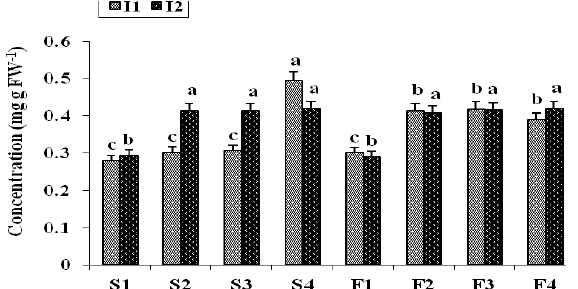
Fig. 5. Changes in superoxide dismutase activity due to water deficit stress and application of Fe;. I1- normal irrigation or irrigation to reach 50% soil moisture depletion of field capacity, I2 beginning of flowering to the end of pollination stage reaching 75% of soil moisture depletion of field capacity; S- soil application of Fe, S1 without soil application of Fe; S2- 50 Fe Kg ha -1 , S3 150 Fe Kg ha -1 ; F- foliar application of Fe, F1- foliar application of water, F2- 1,000 Fe mg l -1 , F3- 2,000 Fe mg l -1 , F4- 3,000 Fe mg l within each column of each section followed by the same letter are not significantly different (p≤0.05)